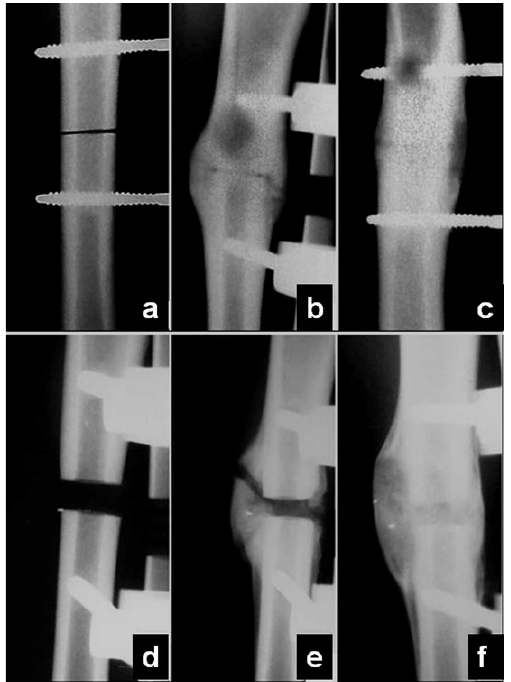
Figure 1 - Radiographic controls for both the linear (above) and resection (below) osteotomies, showing the callus evolution with postoperative time (a and d: immediately afterwards; b and e: 60 days; c and f: 90